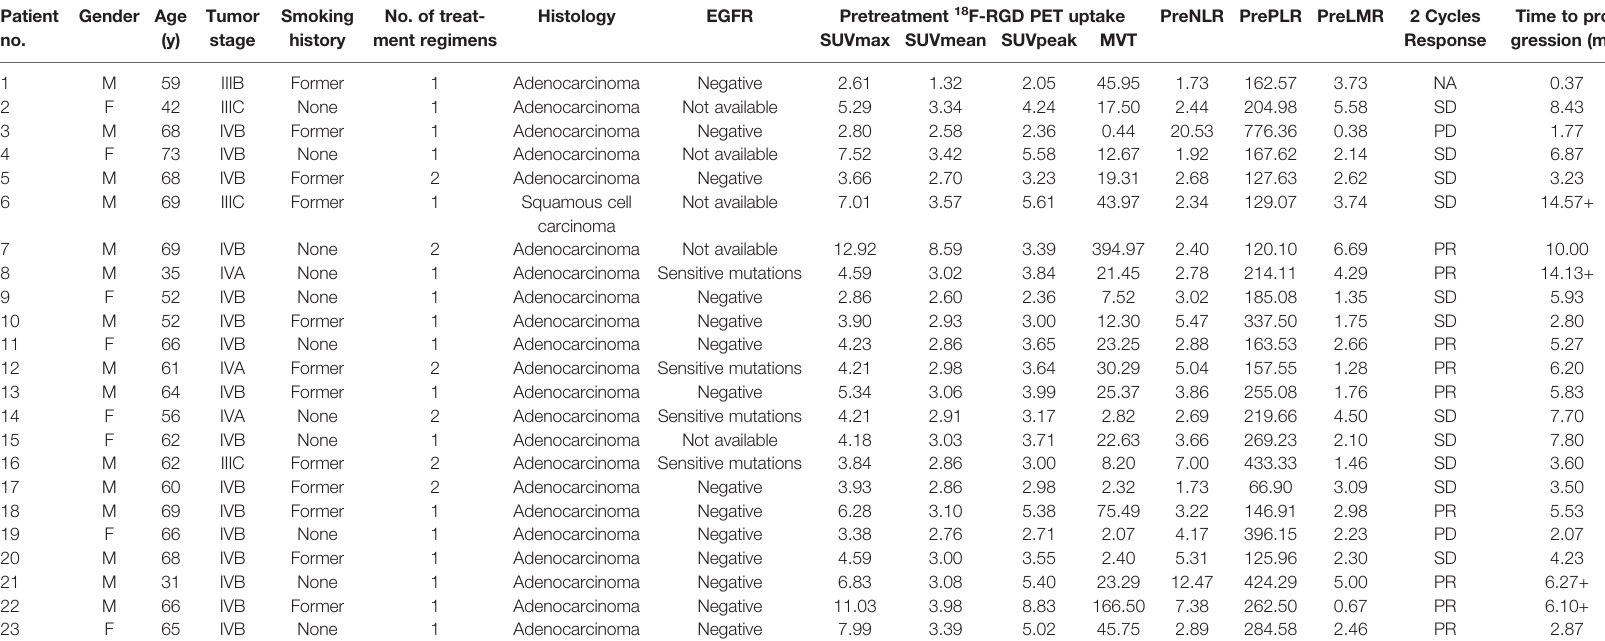
TABLE 2 | Patients characteristics, outcomes, tumor pre-treatment 18 F-RGD PET uptake and in fl ammatory biomarkers. Patient